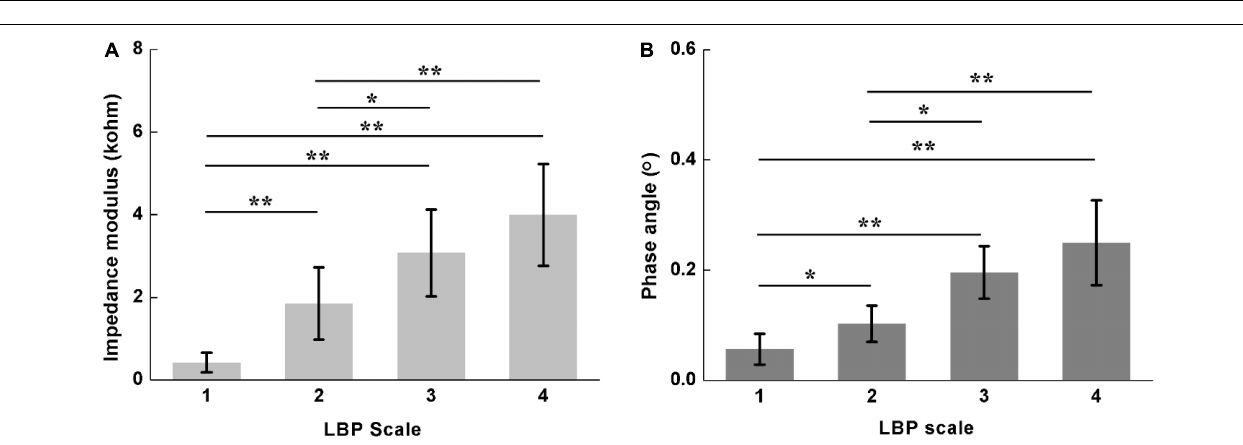
FIGURE 7 | Comparison of difference of lumbar muscle impedance on both sides for different LBP scales, including (A) impedance modulus (Scale 1: 0.42 ± 0.24; Scale 2: 1.85 ± 0.87; Scale 3: 3.08 ± 1.05; Scale 4: 3.99 ± 1.23) and (B) phase angle (Scale 1: 0.06 ± 0.03; Scale 2: 0.10 ± 0.03; Scale 3: 0.20 ± 0.05; Scale 4: 0.25 ± 0.08). LBP Scale 1–4 represents no pain, mild dysfunction, moderate dysfunction and severe dysfunction, respectively. *denotes P < 0.05; **denotes P <